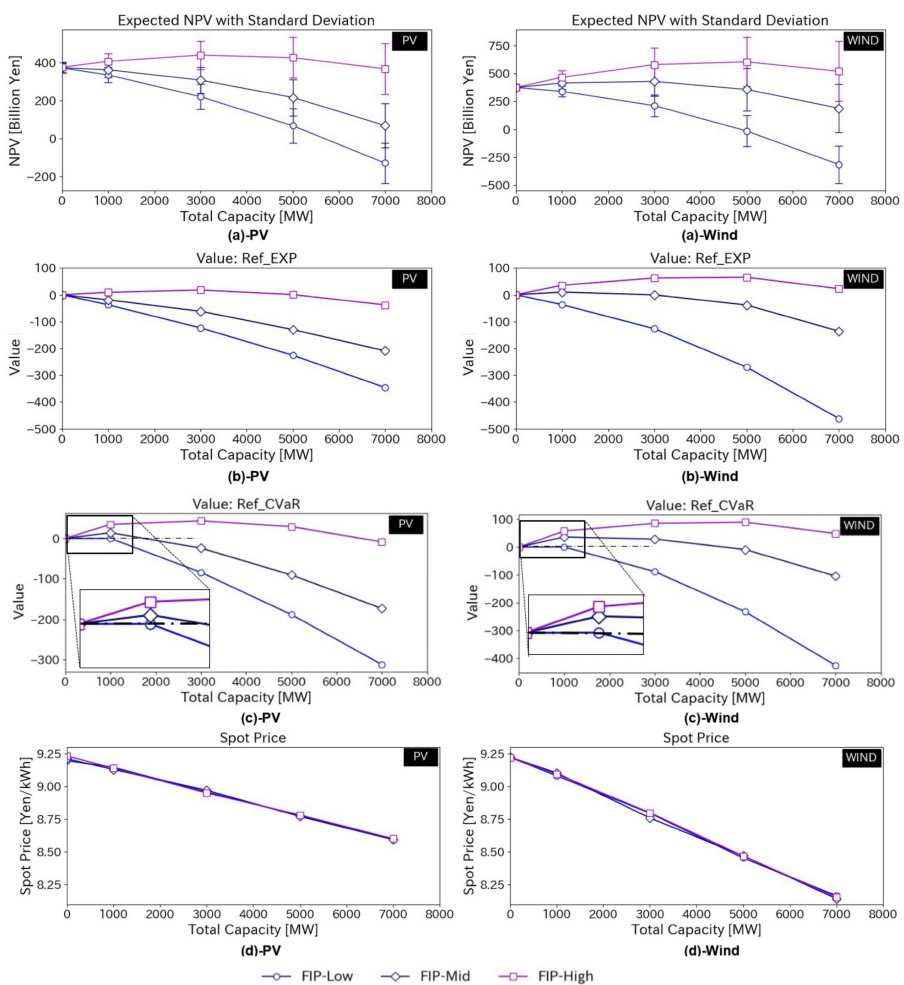
Figure 8. Results of different FIP prices (Low, Middle, and High FIP): ( a ) Expected NPV with standard deviation, ( b ) Value in the case of high RFP, ( c ) Value in case of low RFP and ( d ) Spot price. The horizontal dashed lines show the zero axis in the Value